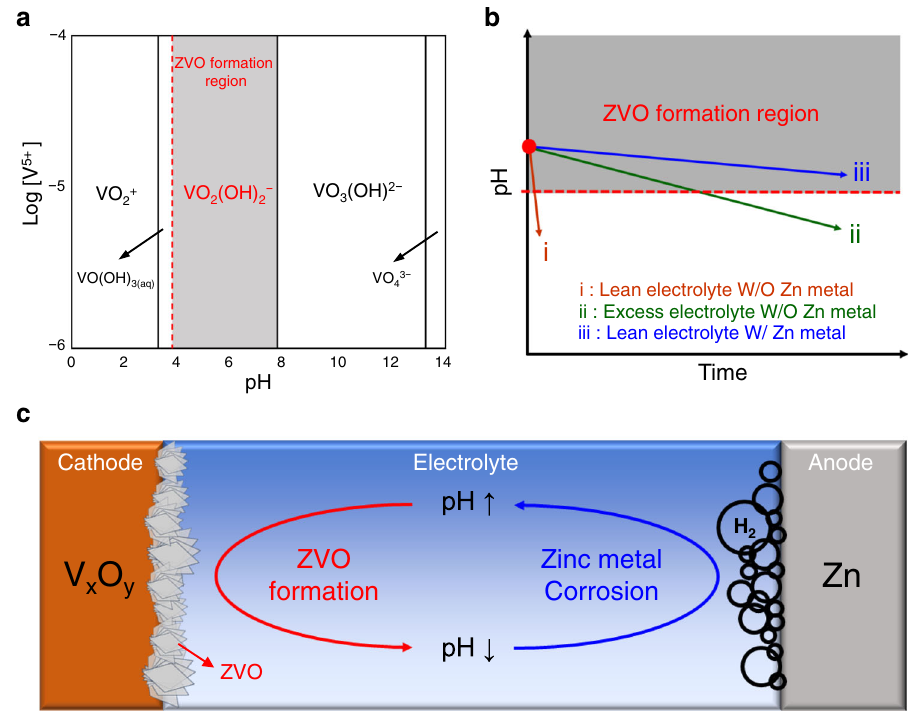
Fig. 4 Dissolution of vanadium oxides and their degradation mechanism in full-cell system. a Predominant V 5 + species in aqueous solutions at 25 °C as a function of vanadium concentration and pH 55 . b Schematic illustration of pH change rate of electrolyte according to test conditions and its correlation with the formation of ZVO. c Schematic illustration of chemical degradation loop in an AZIB cell containing